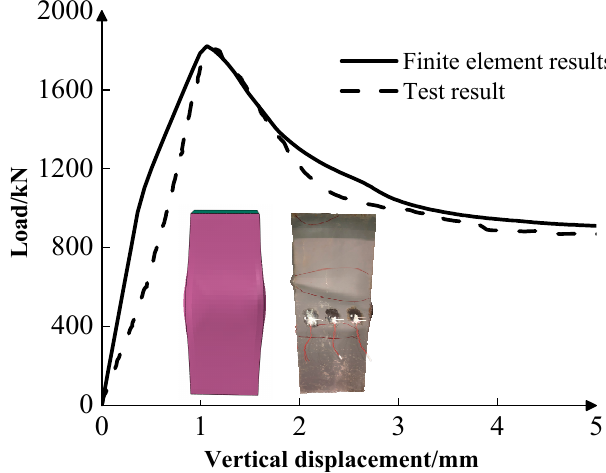
Figure 5. Load-displacement curve.